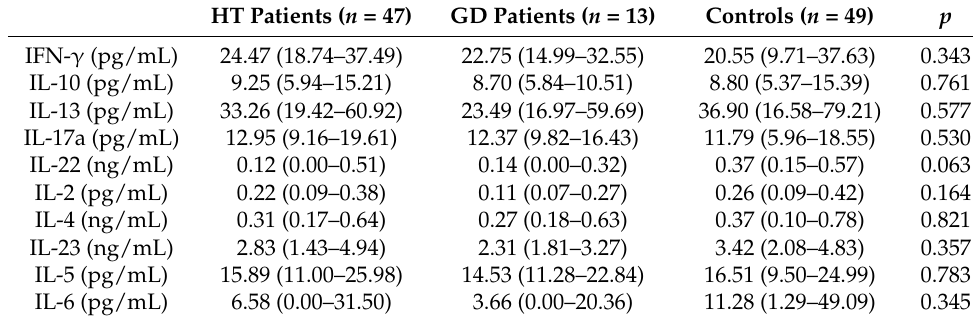
Figure 1. Correlations between selenium parameters and stressful events in HT and GD patients: ( a ) Correlation between SeP and positive stress levels in HT patients. ( b ) Correlation between GPx and negative stress levels in patients with GD. Table 2. Plasma levels of